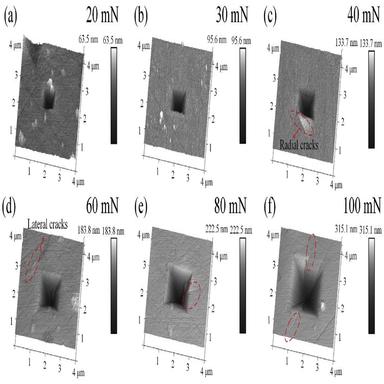
Measured indentation imprints topography with AFM for SiC particle at different load conditions of. (a) 20 mN. (b) 30 mN. (c) 40 mN. (d) 60 mN. (e) 80 mN. (f) 100 mN.